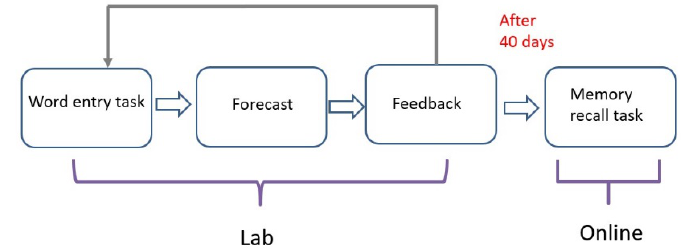
Figure 1. Structure of the Experiment.